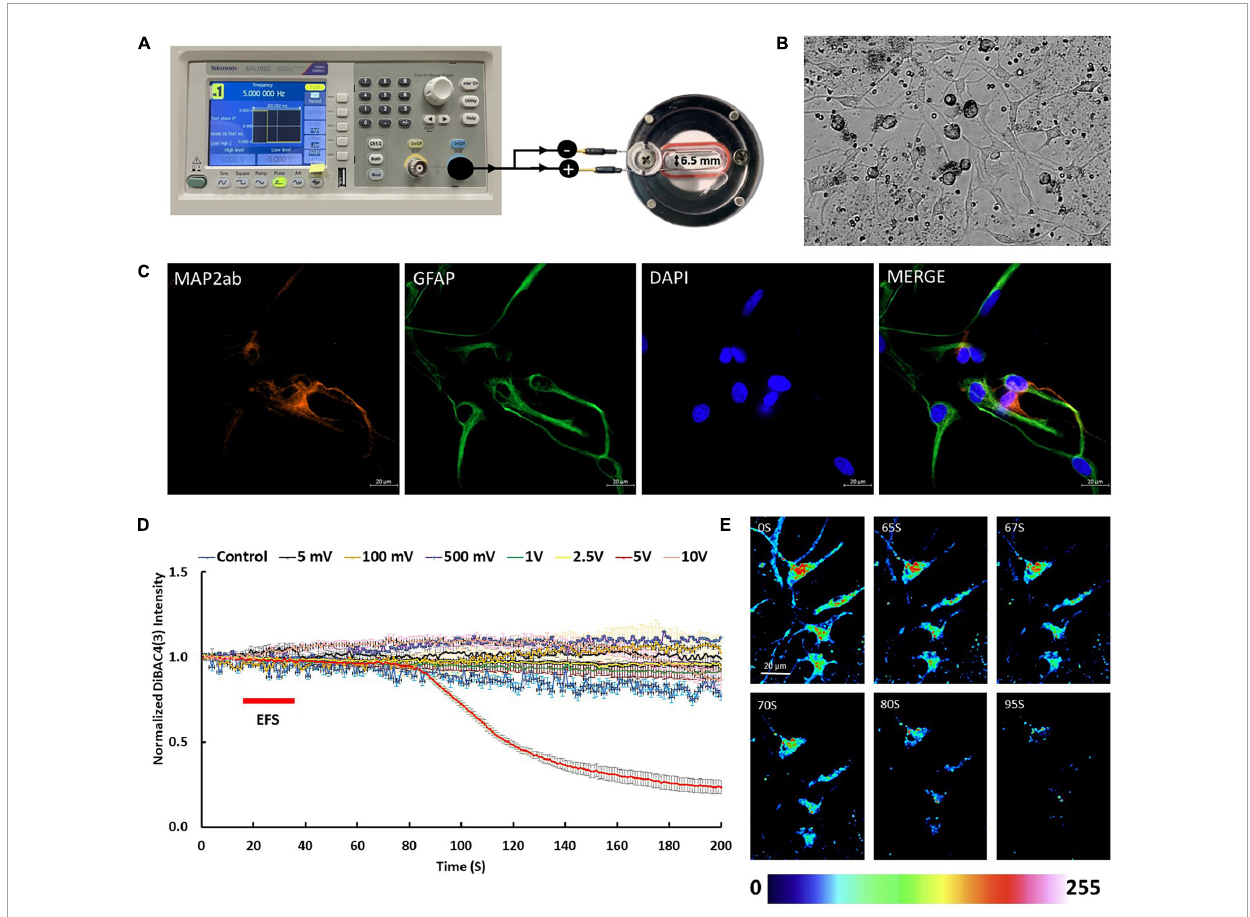
FIGURE1 Electric field stimulation (EFS) protocol and cell cultures used in this study. (A) The experimental set up for delivery of EFS to the rat cortical cultures. Cells on coverslips were transferred into EFS chamber (on the right) which has two electrodes, separated by distance of 6.5 mm. Each electrode has two ends, one end is immersed in the media (700 µ l) and the other end extends outside of the chamber. To apply EFS, the electrodes extending outside of the chamber were connected to a function generator (on the left). The function generator delivered rectangular pulse waves with a width of 200 ms at frequency of 5 Hz. (B) A phase contrast image of rat cortical cultures 5 days post plating. (C) Cortical cultures showed expression of neuronal marker MAP2ab (red) and glial marker GFAP (green). Scale bar = 20 µ m. (D) The graph shows average intensity changes of the membrane potential dye DiBAC4(3) in response to EFS with different voltages, namel ± 5 mV, ± 100 mV, ± 500 mV, ± 1 V, ± 2.5 V, ± 5 V, and ± 10 V. The EFS was applied at second 20 of the experiment for a duration of 20 s. Experiments were conducted in three independent brain preparations, each with three technical repeats. Data shown in (D) represent the average of one independent experiment and is expressed as normalized fluorescence intensity ratio relative to the averaged three images obtained prior to EFS. (E) Sequential confocal images of DiBAC4(3) labeled cortical neurons at the indicated time intervals corresponding to before, during and after exposure to EFS with ± 5 V (calculated EFS intensity of 7.69 V/cm). Scale bar = 20 µ m. Intensity changes in (E) are color-coded whereby high levels are red and low levels are